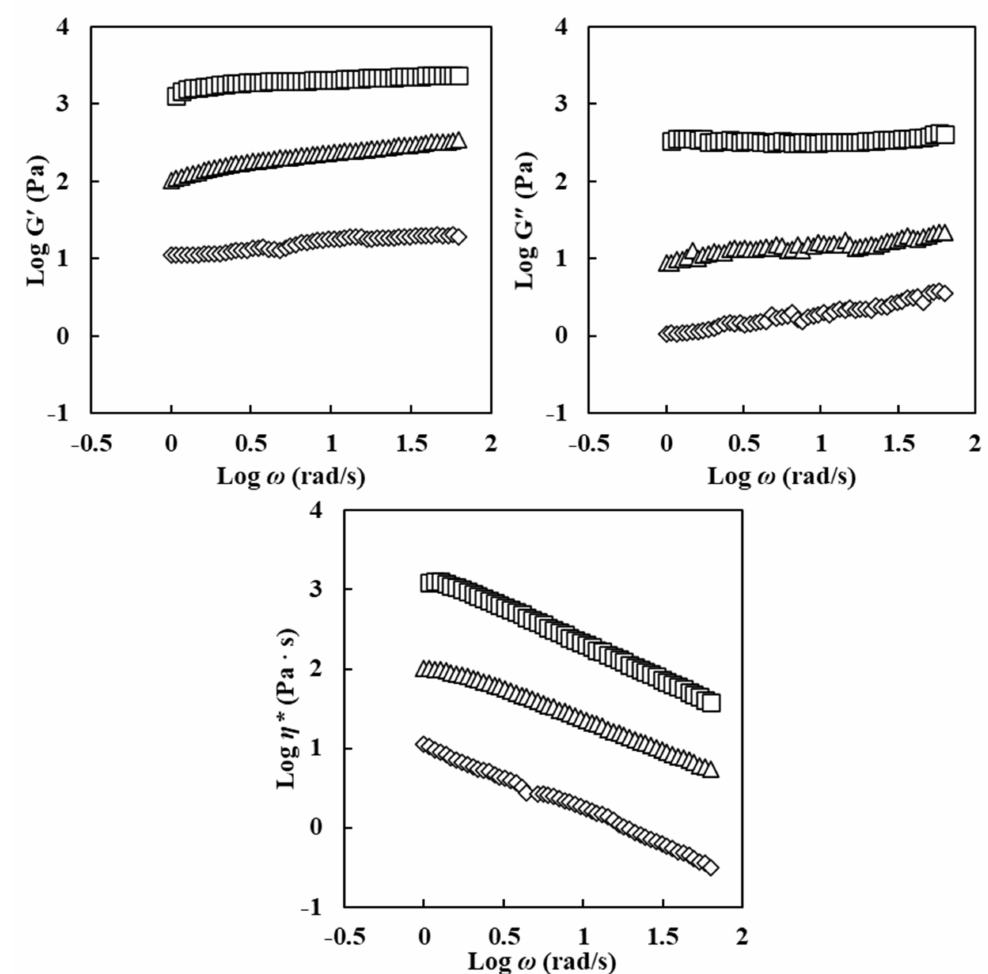
Figure 2. Log storage modulus (G (cid:48) ), log loss modulus (G (cid:48)(cid:48) ), and log complex viscosity ( η * ) vs. log angular frequency ( ω ) for emulsion prepared with different concentrations of esterified rice flour with citric acid (ERCA). (